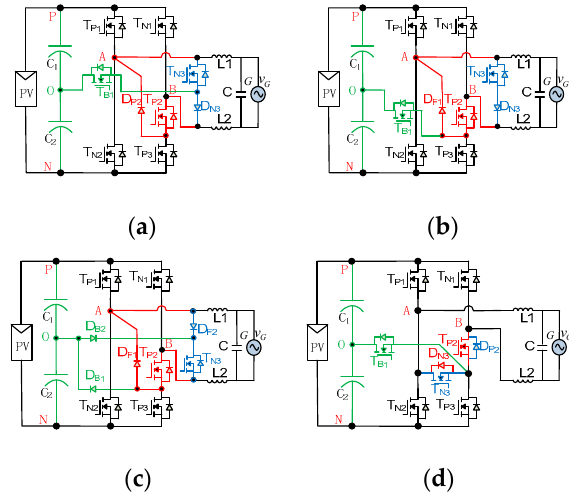
Figure 9. Indirect Connection NPC topologies from M = 2, N = 3 or M = 3, N = 2. ( a ) R4S1-1 [51]; ( b )